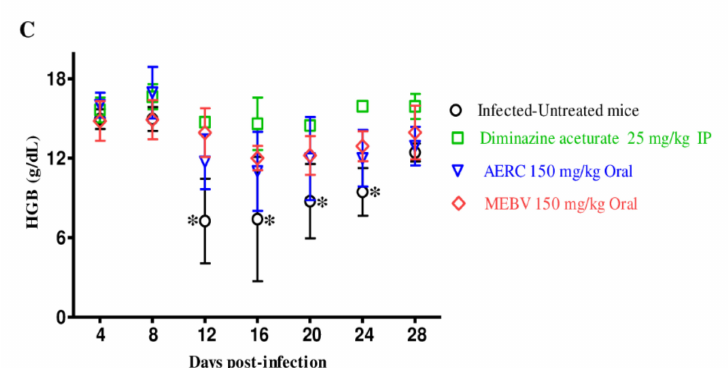
Figure 5. Hematology parameters changes in MEBV- and AERC-treated mice in vivo. Graphs showing the changes in RBCs count ( A ), HCT percentage ( B ), and HGB concentration ( C ) in mice treated with DMA and MEBV and AERC. Asterisks indicate statistical significance ( p < 0.05) based on unpaired t -test